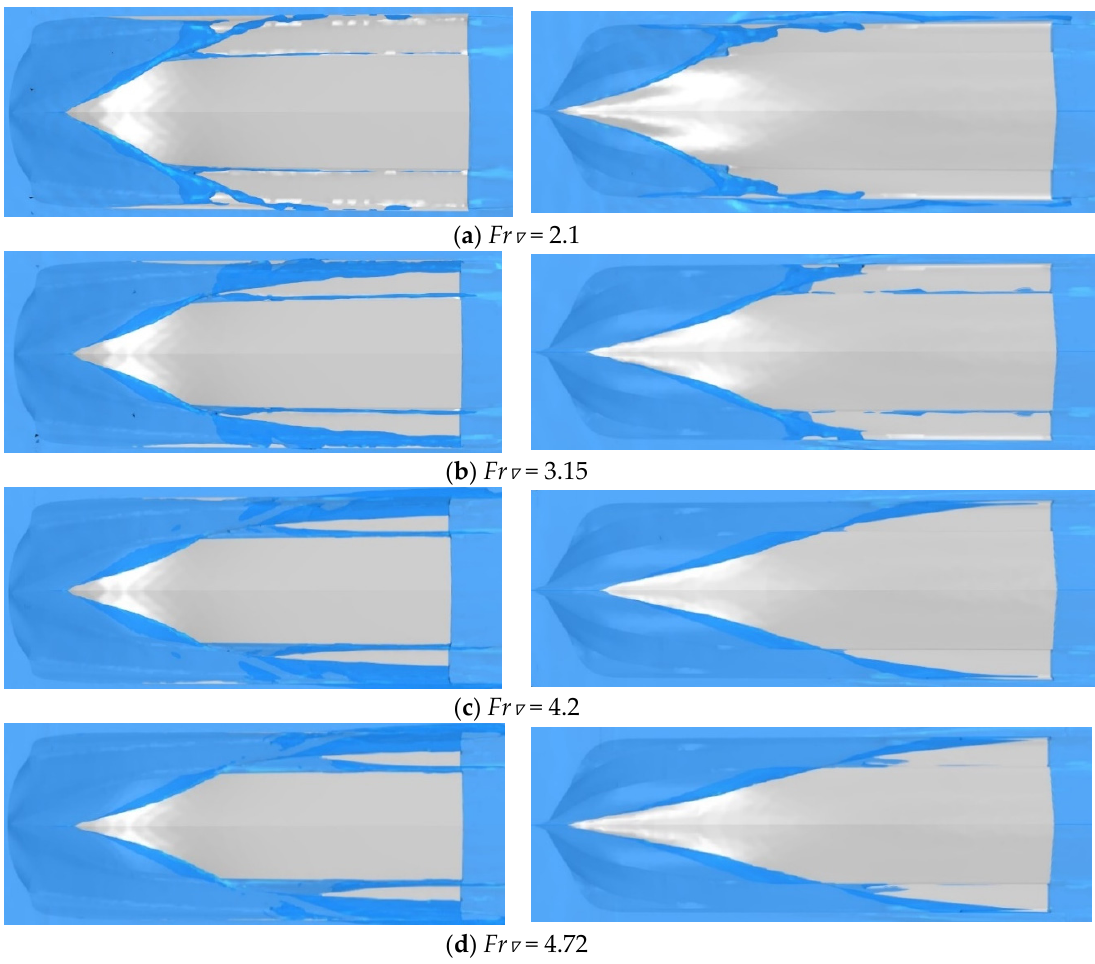
Figure 14. Bottom wetted area analysis of Model a (left) and Model b (right).